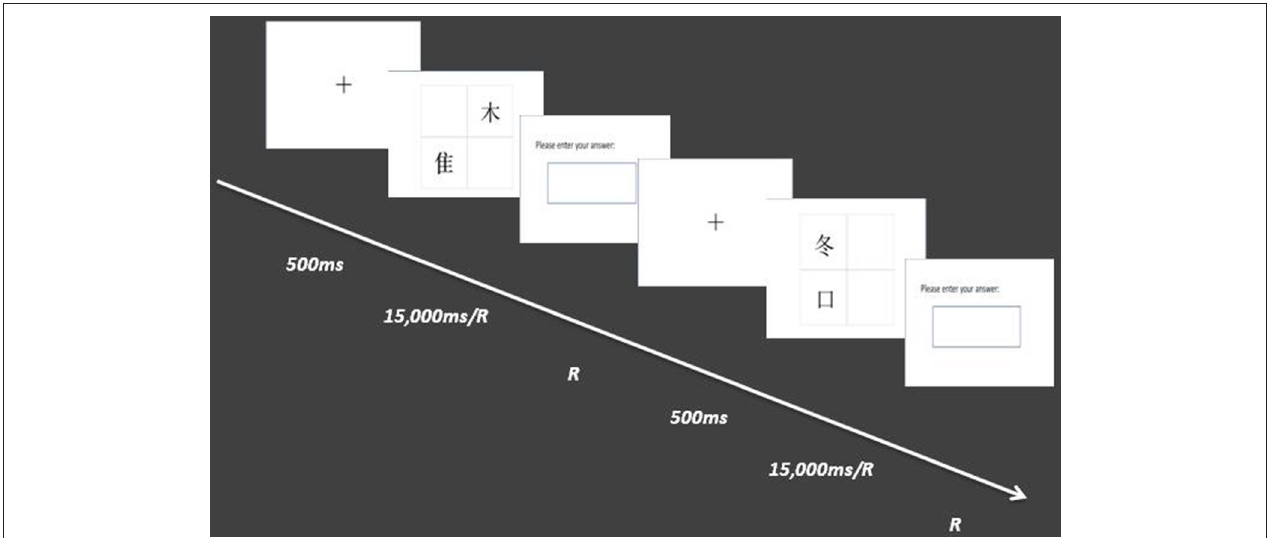
FIGURE 2 | The procedure of experiment 3. the material was presented randomly in the center of the screen for 15,000ms after the fixation. Participants were asked to think of two meaningful characters by combining the two displayed decomposed parts. By generating two meaningful characters through two different organizational methods, he/she should press a response key with the right index finger as soon as possible. A block box was then presented in the next picture immediately, and each participant was asked to write down the spelling of both characters in the box separated with a comma. The procedures of experiments 1 and 2 are similar with experiment